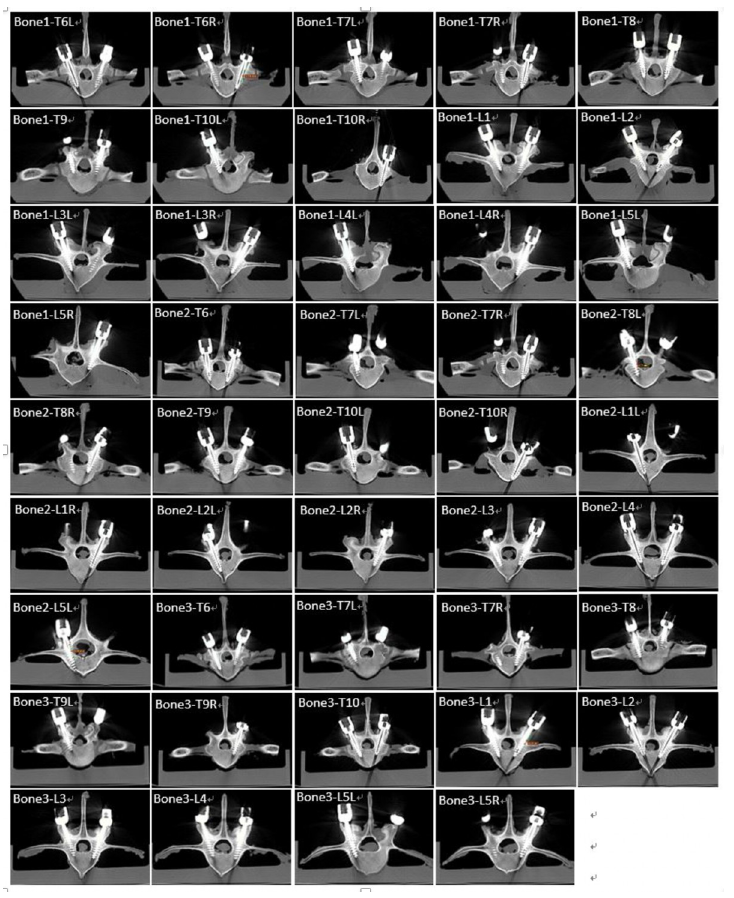
Fig 5. Screw position accuracy measurements determined from postoperative CT